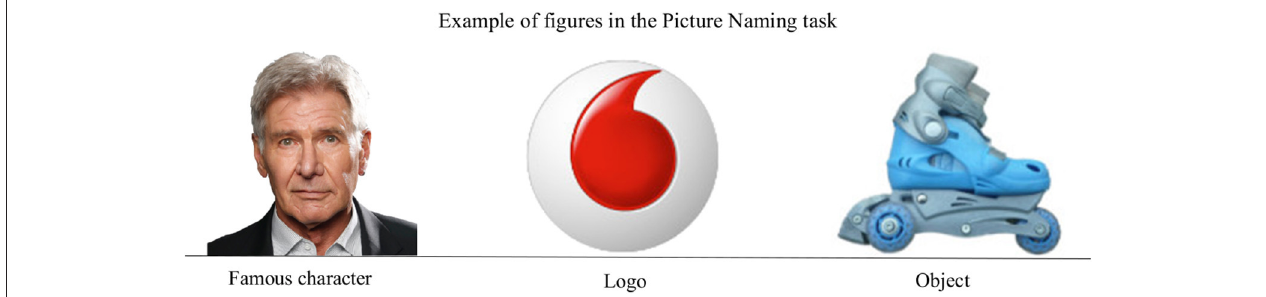
FIGURE 1 | Example of figures of the Picture Naming task: famous character on the left-hand side and Logo image at the center, (https://www.istockphoto.com/ca). Object image on the right-hand side; no permission is required for the use of this image (Moreno-Martínez and Montoro, 2012).